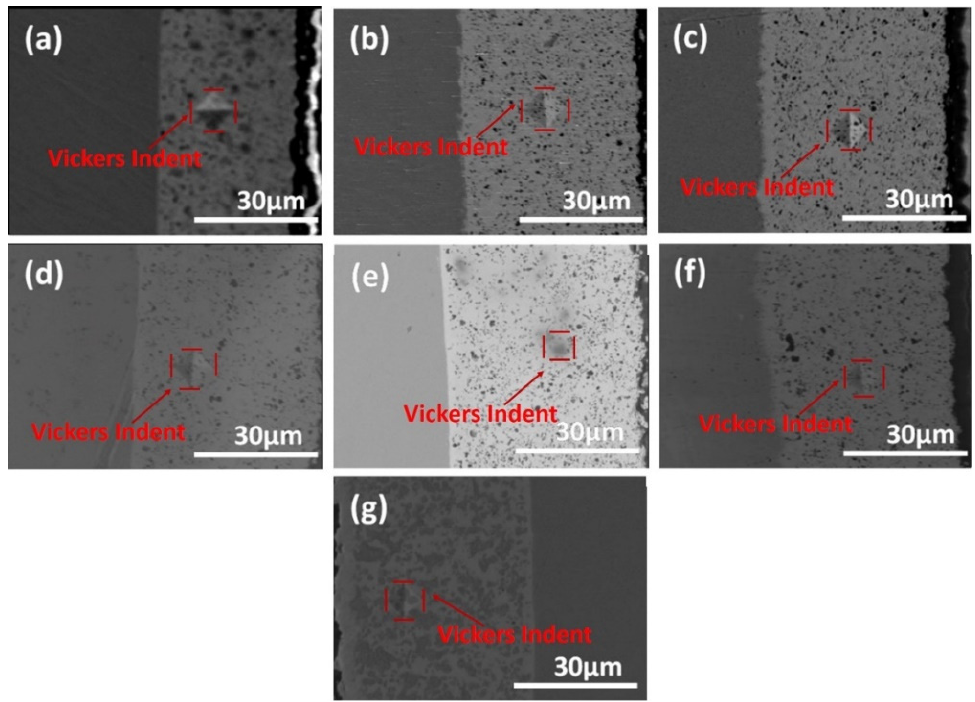
Figure 2. Cross-sectional SEM images of the Ni-W/B coating obtained at 75 °C, 5 g/L boron concentration, 0.1 A/cm 2 current density and 8.9 pH and various heat treatment temperatures ( a ) as-deposited, ( b ) 200 °C, ( c ) 300 °C, ( d ) 400 °C, ( e ) 500 °C, ( f ) 600 °C, ( g ) 700 °C.